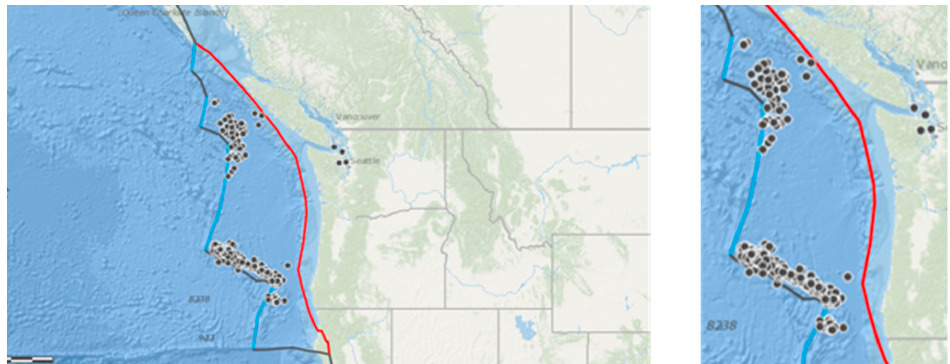
Figure 2. Left : The Cascadia basin showing subduction (red line) and a collection of transform faults (black lines) superimposed with earthquakes M > 4 (points) between 2005 and 2010; Right : the study area. Maps produced by ARCGIS online (Copyright © 1995–2017 Esri).